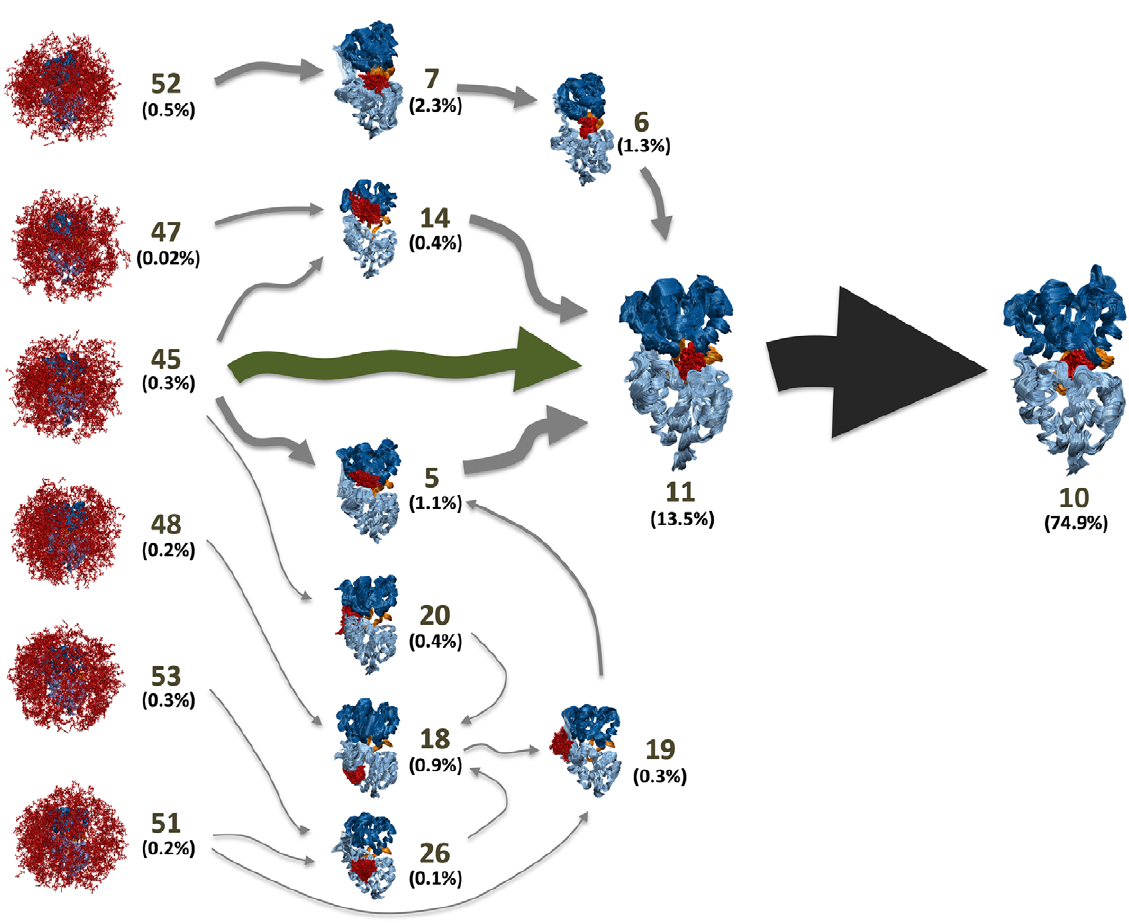
Figure 3. Superposition of the 10 highest flux pathways from the unbound states to the bound state. The flux was calculated using a greedy backtracking algorithm [31,66] applied to a 54-state MSM generated with the SHC algorithm [30]. These pathways account for 35% of the total flux from unbound states to the bound state. The arrow sizes are proportional to the interstate flux. State numbers and their equilibrium population calculated from MSM are also shown. The conformational selection and induced pathways from the unbound states to the encounter complex state is shown in green and grey arrows respectively.